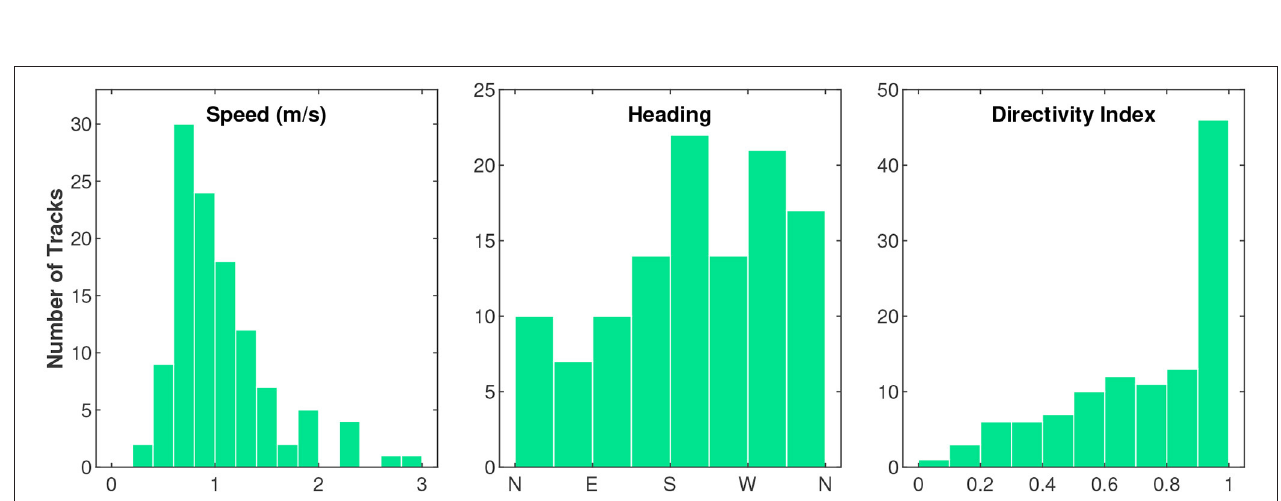
FIGURE 3 | Histograms of the average speed (m/s), overall heading, and directivity index (straight-line distance traveled divided by the total distance traveled) for each fin whale track.